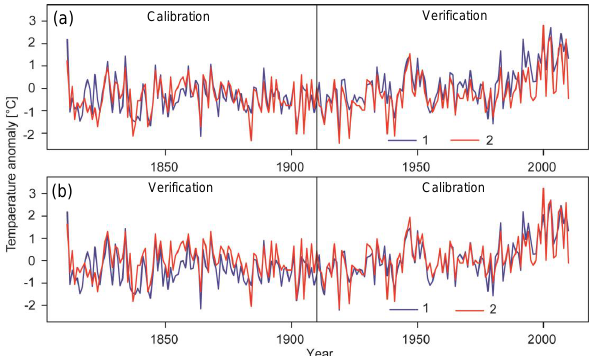
Figure 7. Comparison of measured (continuous blue line) and re- constructed temperatures using regression ( a – green line) and scal- ing ( b – red line) presented in rank order; dashed boxes indicate the upper and lower 10% portions of measured temperatures and numbers of these extremes reproduced in